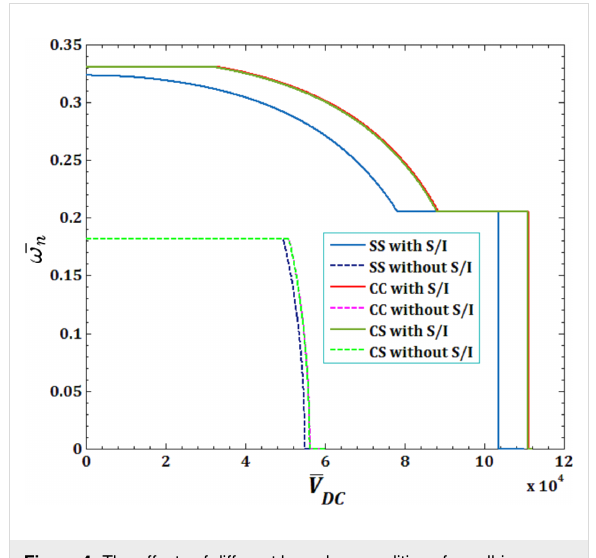
Figure 4: The effects of different boundary conditions for pull-in voltage on DNF of FC-MWPENS.